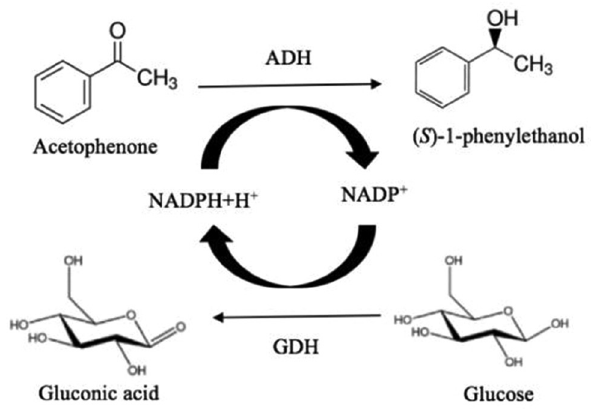
Figure 1: Asymmetric bioreduction of acetophenone catalyzed by Ispir bean.